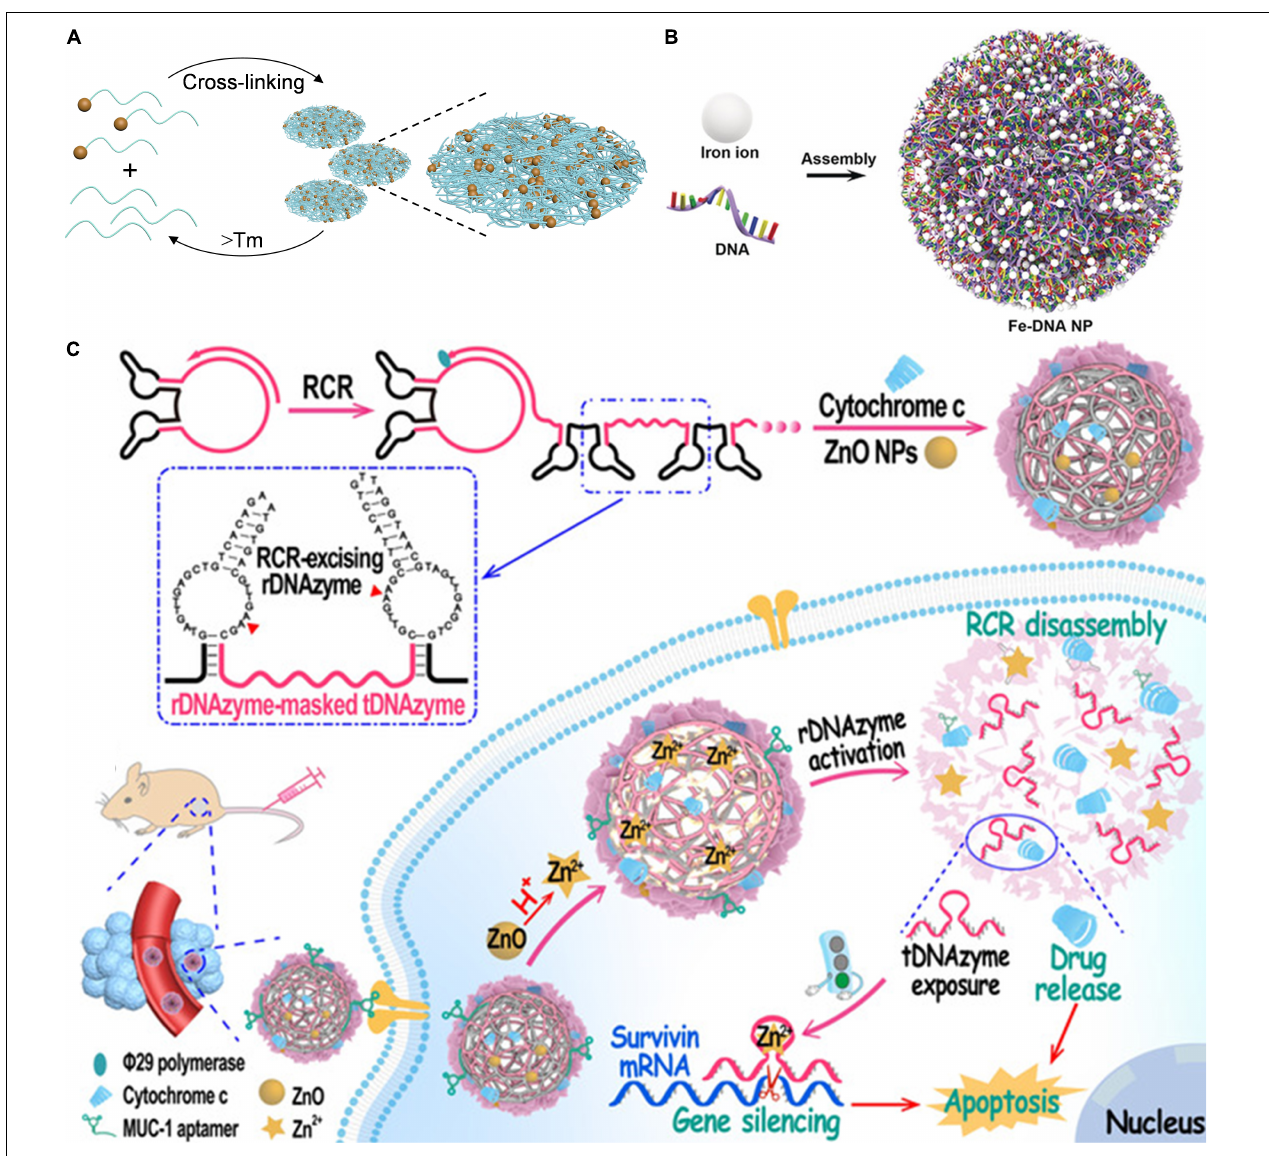
FIGURE 3 | DNA-inorganic nanoassembly for nucleic acid-based drugs delivery. (A) Gold-DNA nanoassembly for efficient gene silencing with controllable transformation. Adapted with permission from ref. Huo et al. (2019). Copyright 2019, Science Publishing Group. (B) Engineering Multifunctional DNA hybrid nanospheres through coordination-driven self-assembly for CpG delivery. Adapted with permission from ref. Li M. et al. (2019). Copyright 2019, Wiley-VCH. (C) DNA nanoflower for multifunctional DNAzyme delivery. Adapted with permission from ref. Wang et al. (2021). Copyright 2021,